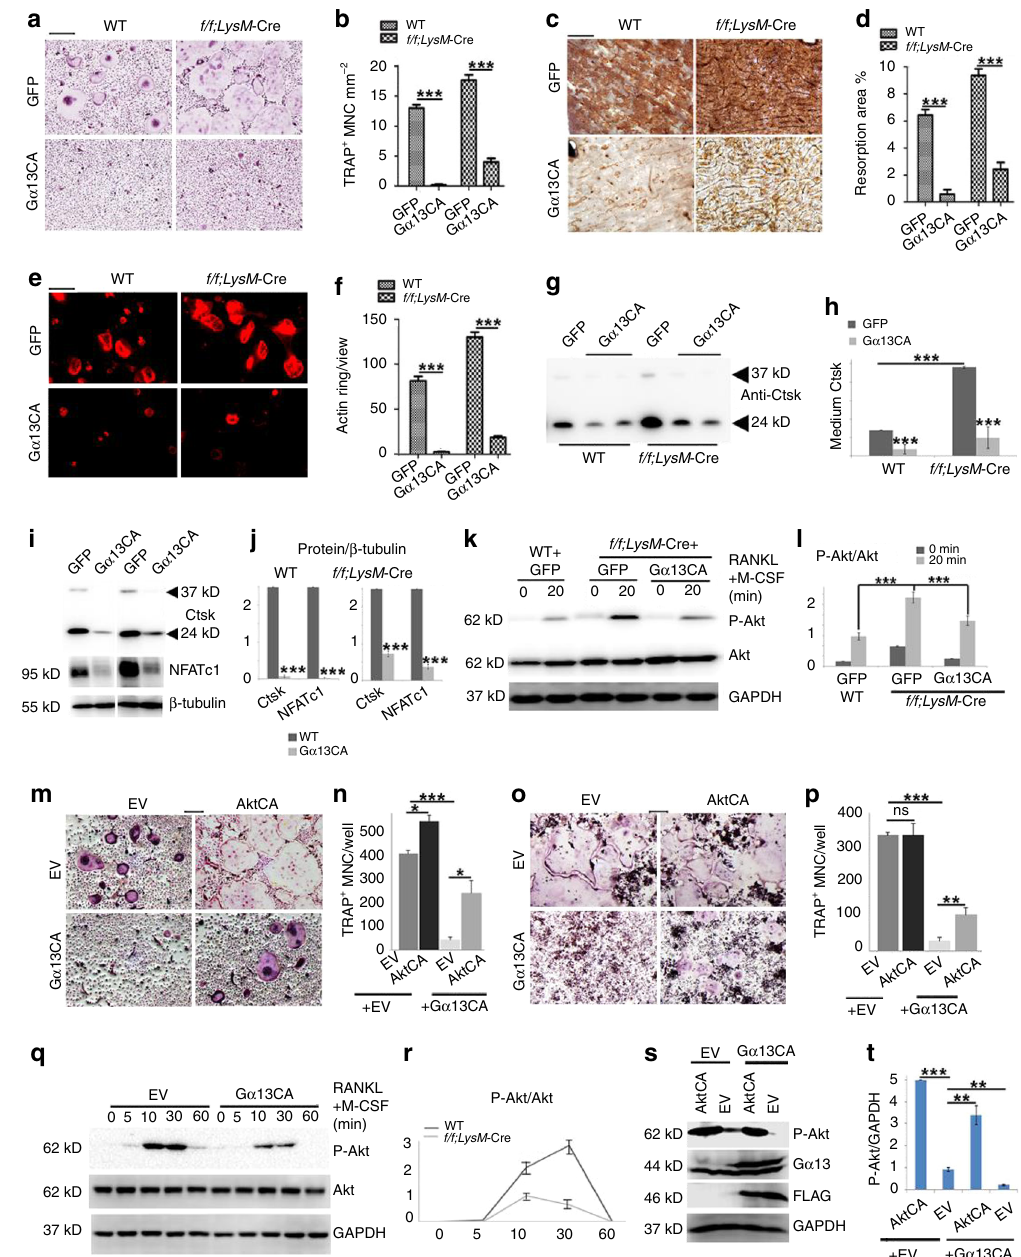
Fig. 2 Ga13 gain-of-function inhibits osteoclast formation and function in